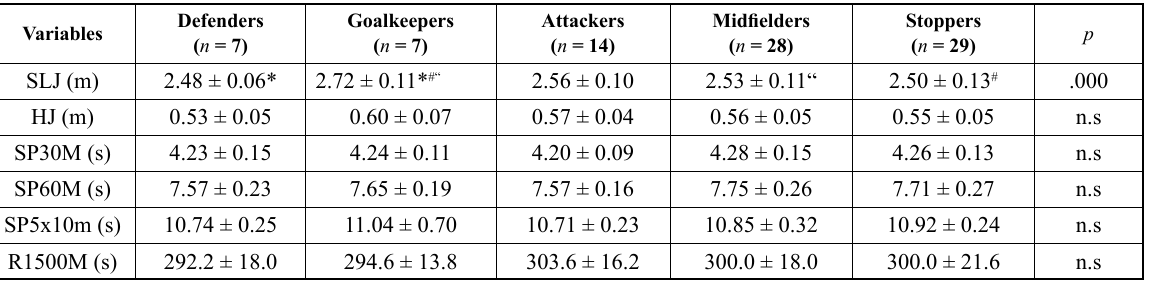
Table 1. Descriptive parameters and significant differences between group (mean ± standard deviations) Variables